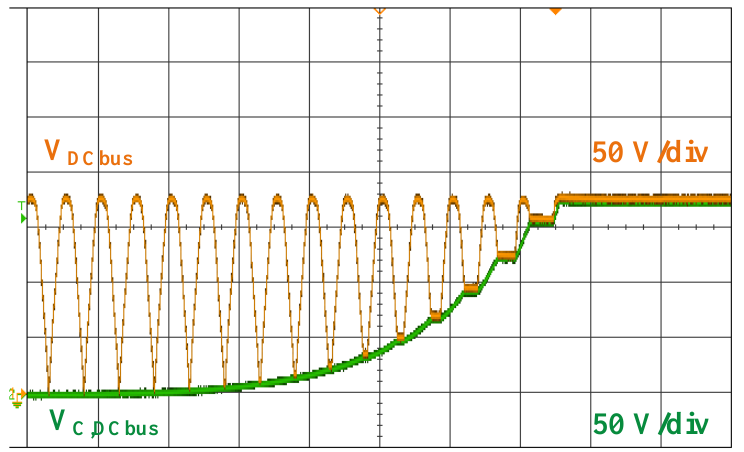
Figure 11. DC bus voltage V DC,bus (yellow) and the DC bus capacitors voltage V C,DCbus (green) during start-up.